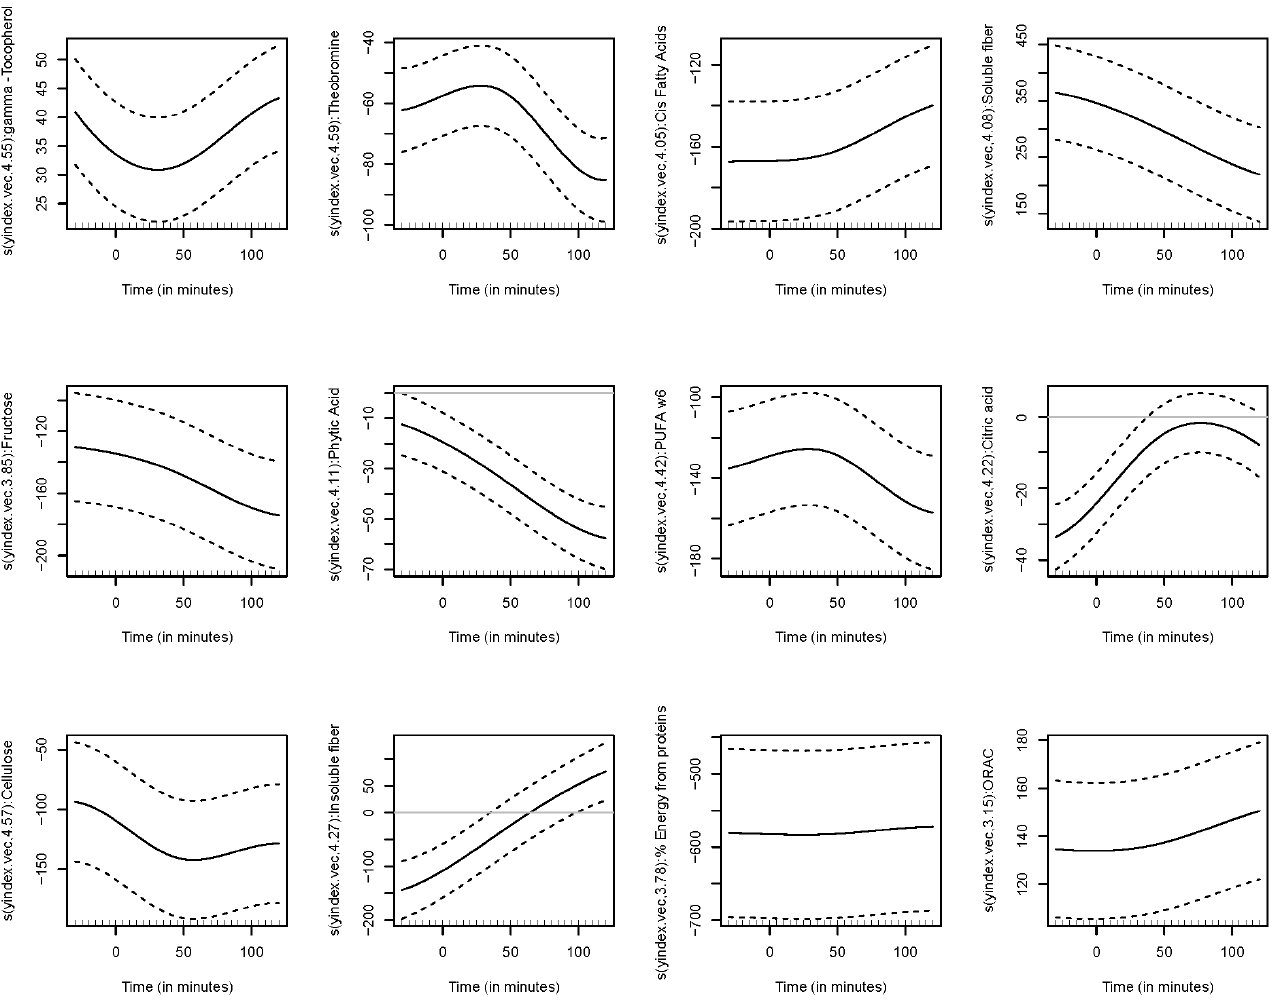
Figure 6. Functional coefficient patterns of nutritional variables.